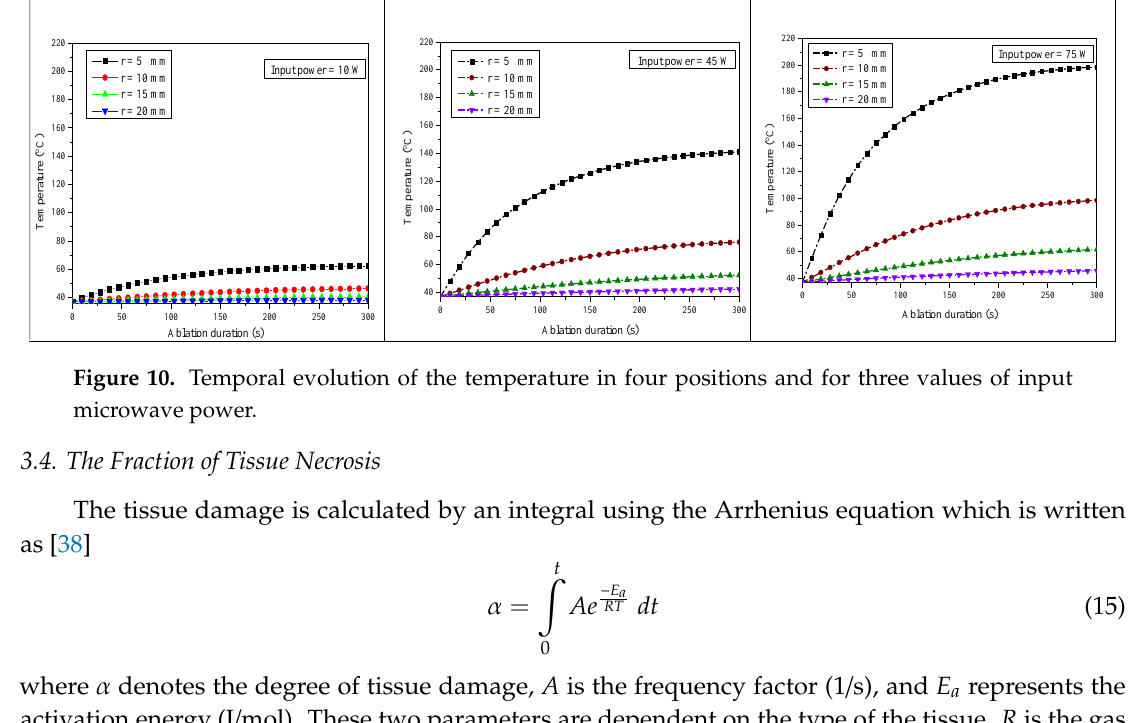
Figure 9. Spatial distribution of ( ∆ T = T − T blood ) for various input powers at t = 300 s.